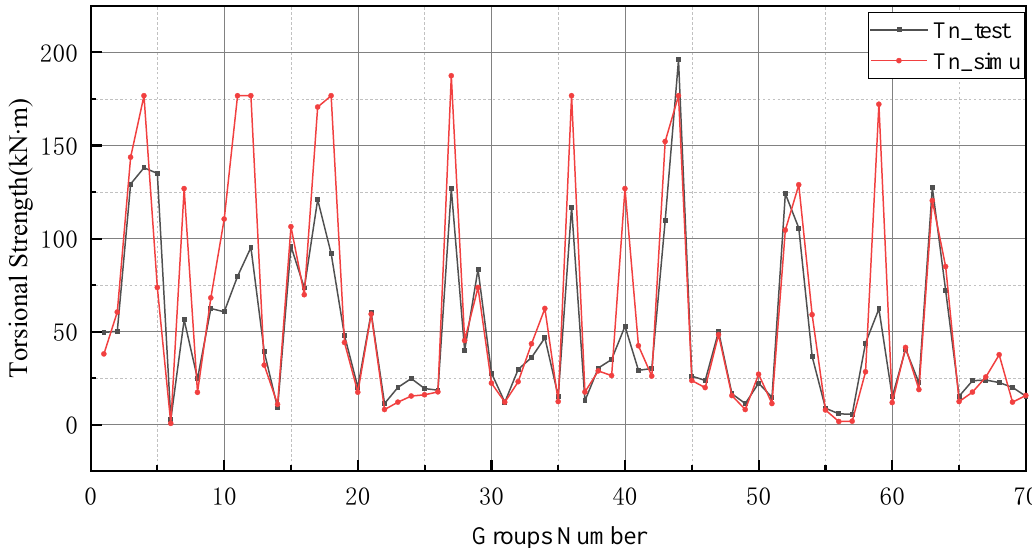
Figure 12. Prediction of torsional strength of ACI-318-14.